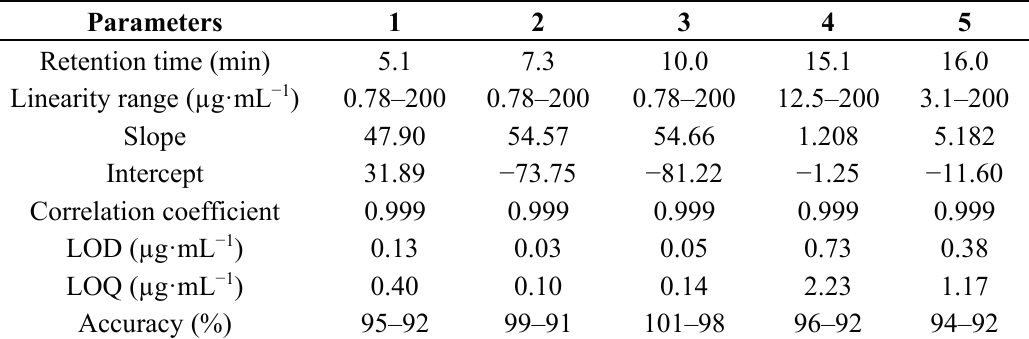
Table 4. Validation parameters for compounds ( 1 – 5